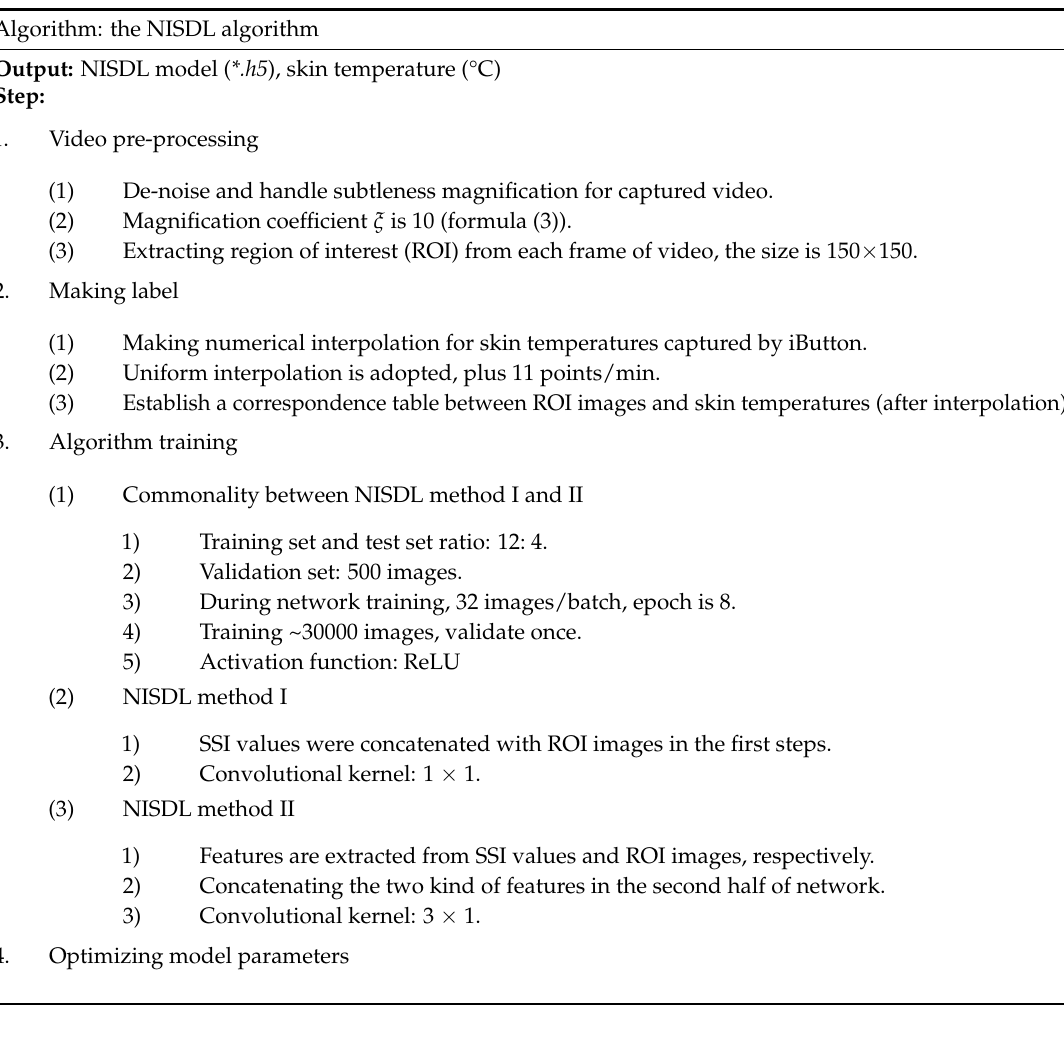
Table 1. Contactless measuring method of skin temperature based on skin sensitivity